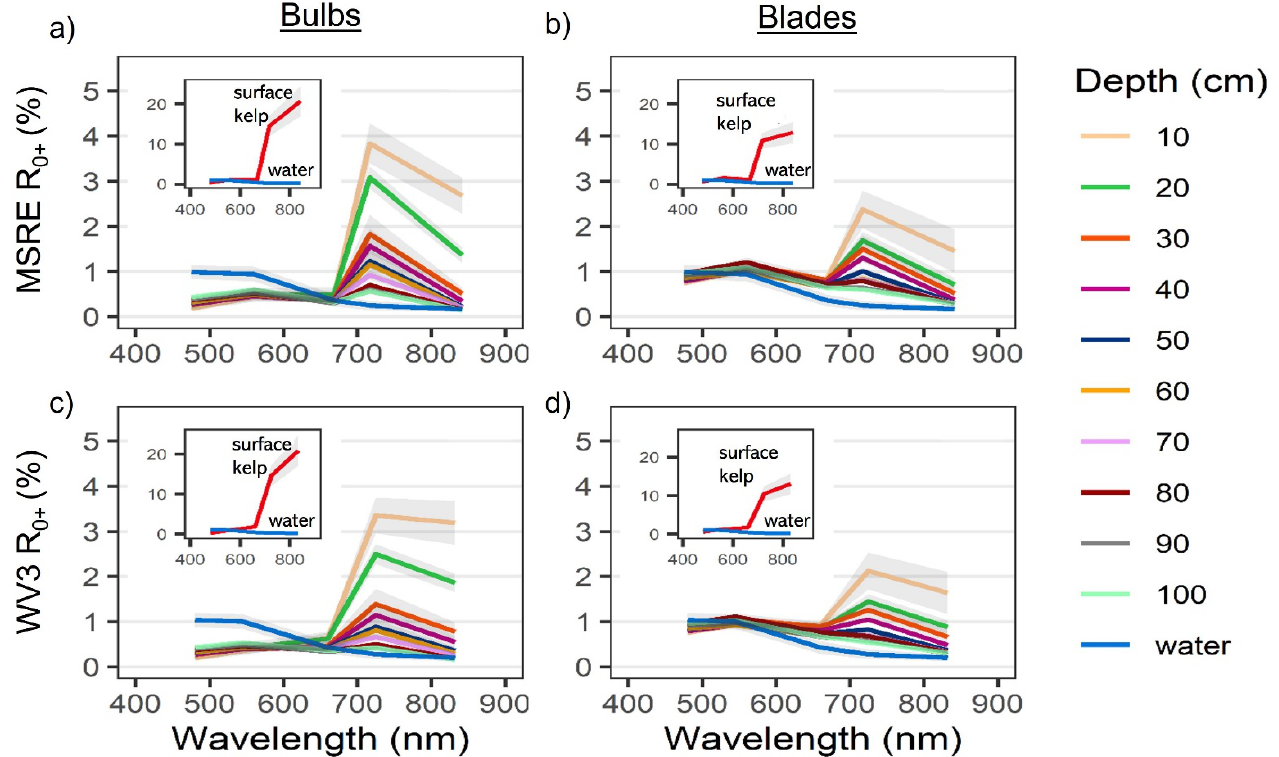
Figure 5. Reflectance values (R0+) for bulbs ( a , c ) and blades ( b , d ) of simulated bands (mean +/ − sd) shared by the Micasense RedEdge-MX (MSRE; a , b ) and WorldView-3 (WV3; c , d ), derived from the hyperspectral data (Figure 3) using Gaussian response functions (Figure 2).